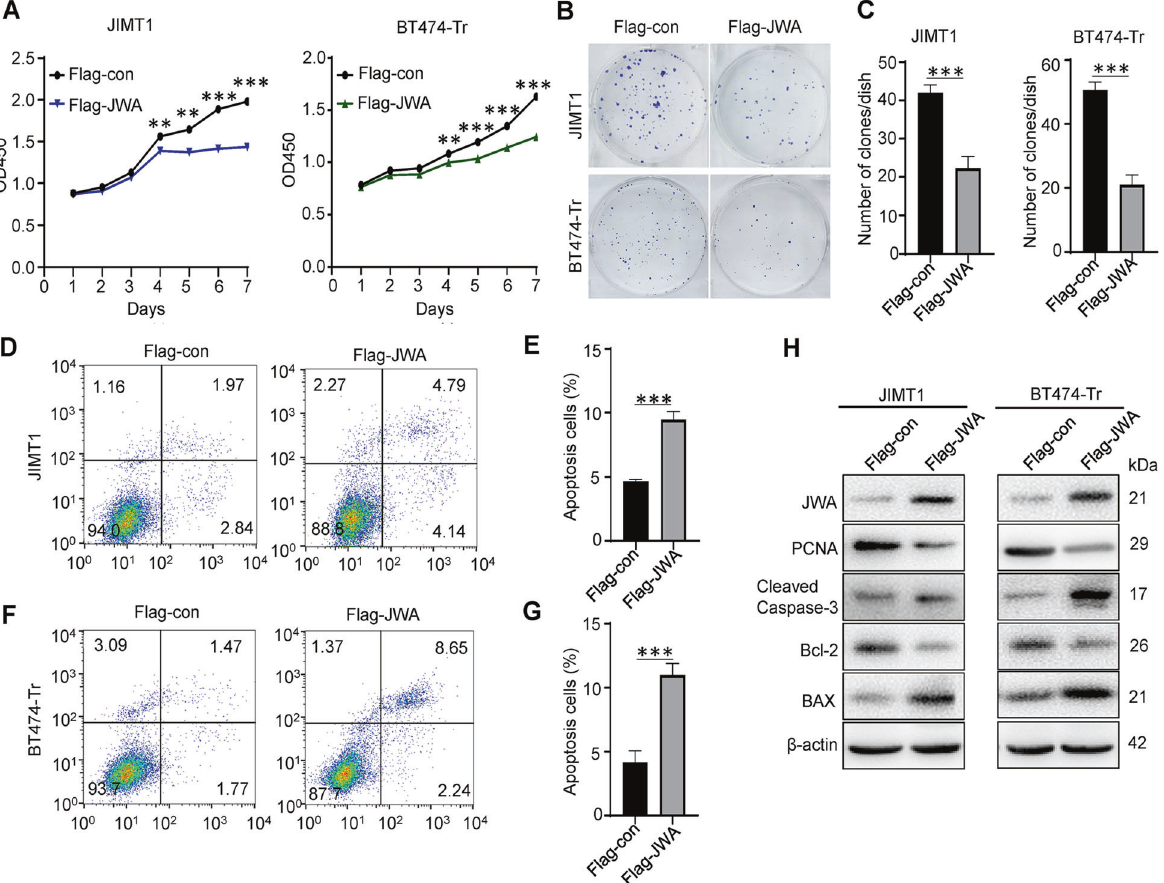
Fig. 3 JWA suppresses proliferation and promotes apoptosis in trastuzumab-resistant breast cancer cells in vitro. A Overexpression of JWA signi fi cantly increased the inhibition rate of tumor cells in JIMT1 and BT474-Tr cells by CCK-8. B , C Overexpression of JWA inhibited cell proliferation in JIMT1 and BT474-Tr cells as determined by colony formation assays. D , E Apoptotic cells increased after overexpression of JWA in JIMT1 cells. F , G Apoptotic cells increased after overexpression of JWA in BT474-Tr. H Overexpression of JWA in JIMT1 and BT474-Tr cells inhibited cell proliferation and promoted apoptosis as assessed by Western blot. Statistical analysis was performed using Student ’ s t-test. * P < 0.05, ** P < 0.01, *** P < 0.001, ns statistical